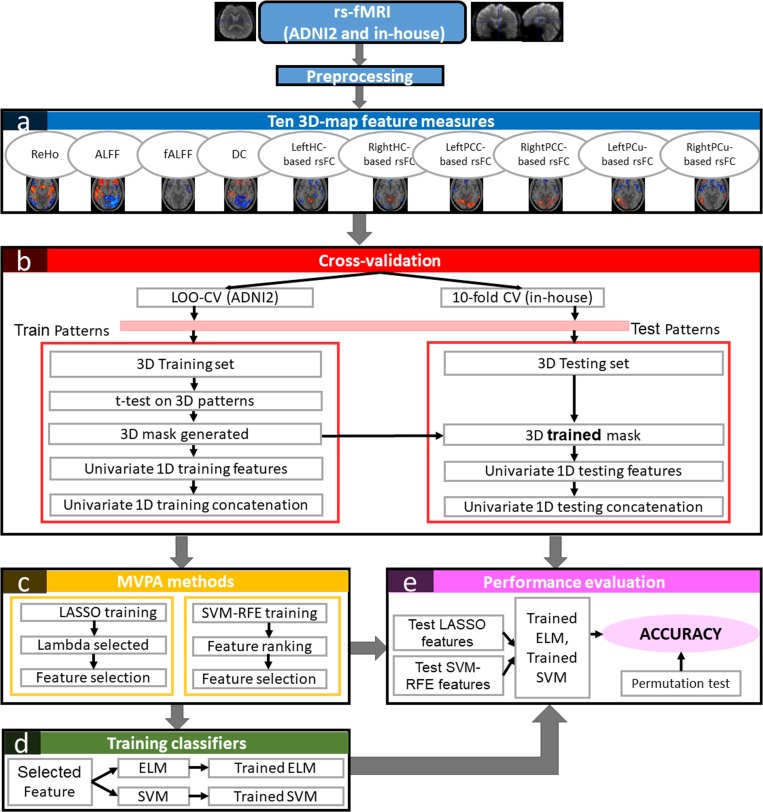
Descriptions of the proposed framework in this study.Block (a) presents the 3-D feature measure extractions from preprocessed fMRI scans. Block (b) describes the LOO-CV and 10-fold-CV cross validation for ADNI2 and in-house cohorts, respectively. Block (c) presents the multivariate feature reduction techniques using LASSO and SVM-RFE. The combined univariate t-test and multivariate LASSO as well as SVM-RFE informative features are trained by ELM and SVM classifiers as illustrated in block (d). Finally, the trained classifiers and testing features are used to evaluate the performance as in block (e).